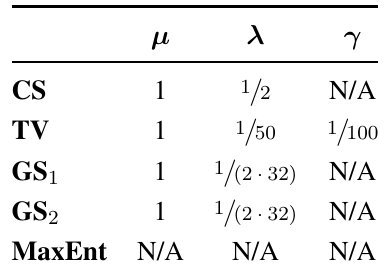
Table 1. Lagrange multiplier values used during reconstruction. The GS reconstructions use the CS parameter values scaled by the number of coefficients per group. The MaxEnt reconstruction does not use Lagrange